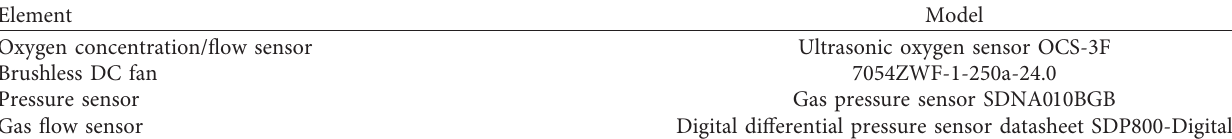
Table 1: Component selection of a new type of high flow nasal oxygen therapy equipment.